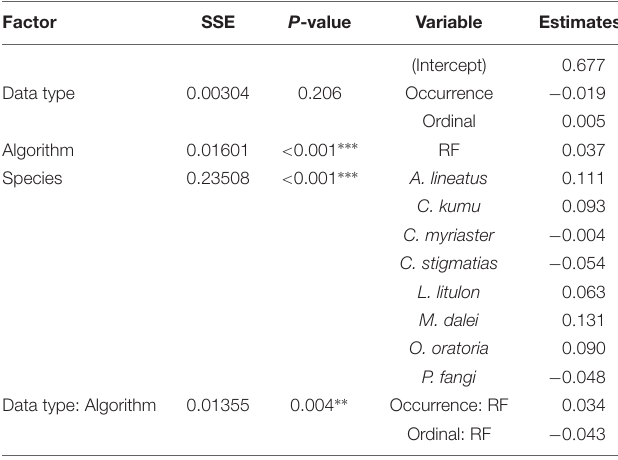
TABLE 3 | The effects of data type, algorithm and species on performance metric (AUC) for predictions on binary occurrence by ANOVA.